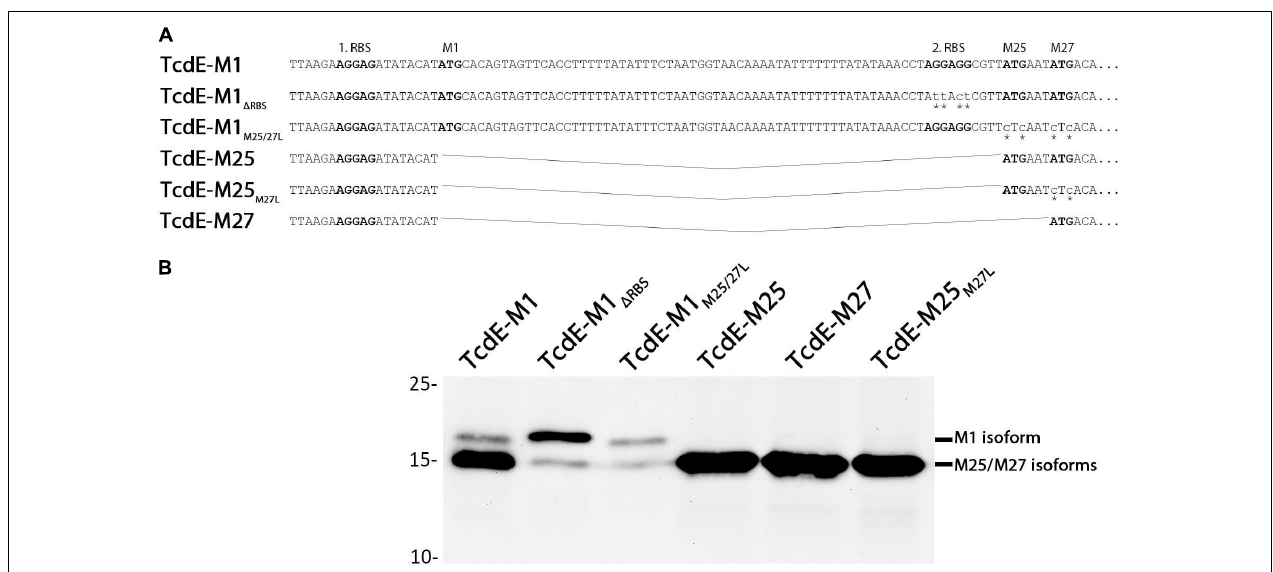
FIGURE 1 | Analysis of the translation of the three distinct TcdE isoforms in E. coli . (A) Constructs for the production of TcdE isoforms that initiate translation at M1, M25, or M27, with or without an inactivated second ribosomal binding site ( (cid:49) RBS) or translational start at M25 or M27, as indicated. Mutated bases are labeled by asterisks. Ribosomal binding sites and translational starts are in bold letters. (B) SDS–PAGE/Western blot detection of M1 and M25/M27 isoforms produced by the E. coli strains ER2566 pBW- tcdE-M1 -H6, pBW- tcdE -M1 (cid:49) RBS -H6, pBW- tcdE -M1 M25 / 27L -H6, pBW- tcdE -M25-H6, pBW- tcdE -M27-H6, and pBW- tcdE -M25 M27L -H6, respectively, using specific His-tag antibodies and ECL reaction. Induction was with 0.1% rhamnose. Molecular weight markers (in kDa) are indicated on the left.